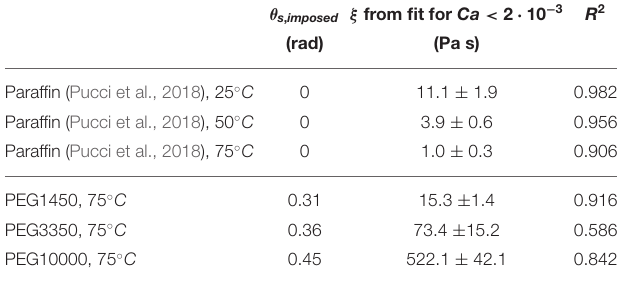
TABLE 5 | Obtained parameters from MKT fit at low Ca for partially and totally wetting polymers.